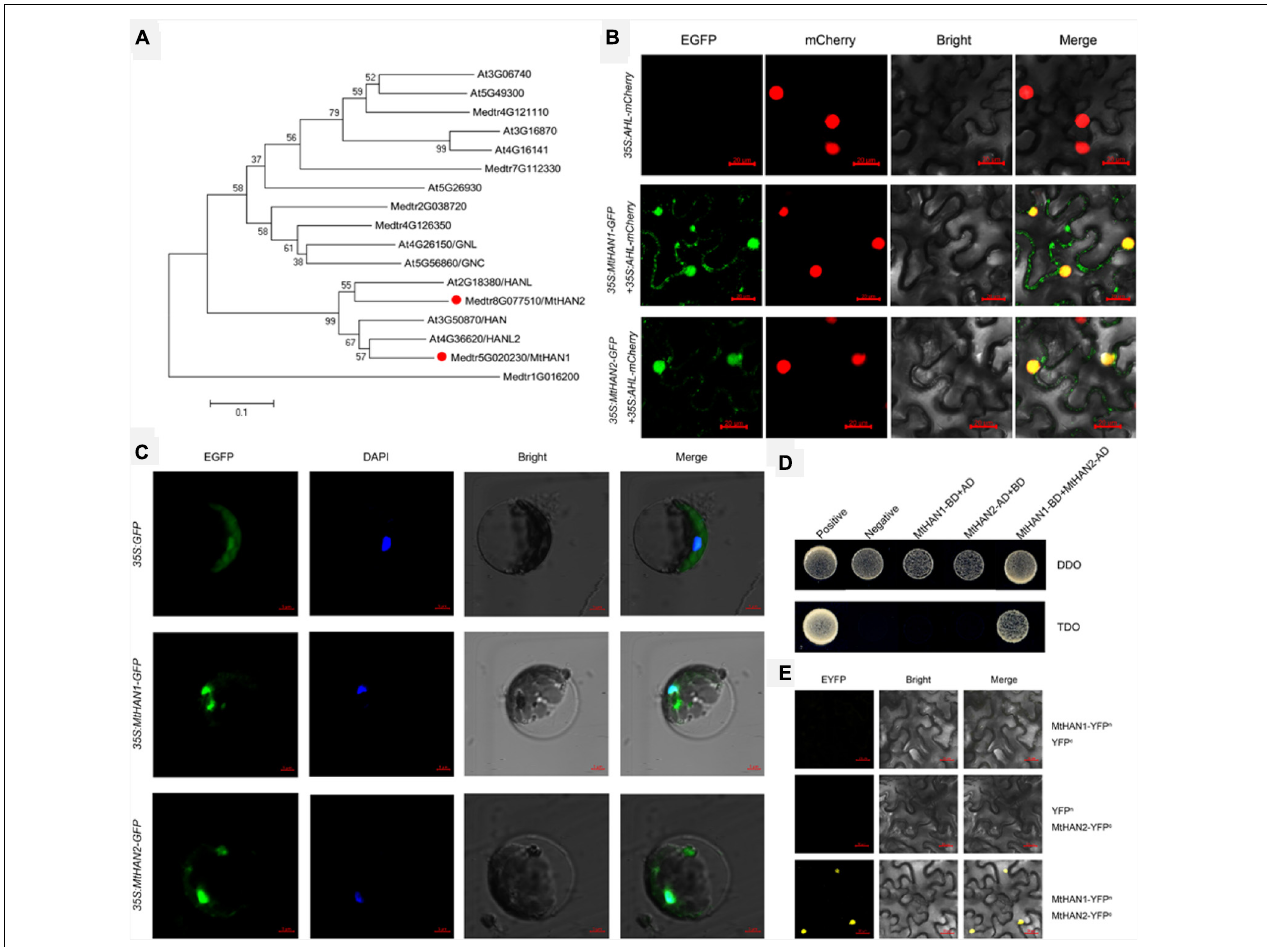
FIGURE 1 | Medicago truncatula HANABA TARANU ( HAN ) homologues interact in nucleus. (A) Phylogenetic analysis of HAN genes among different species. (B) The subcellular localization of MtHAN1 / 2 -GFP in Nicotiana benthamiana leaves. At-Hook Motif Containing Nuclear Localized (AHL)-mCherry was used as a marker for the nucleus. Bars = 20 µ m. (C) The subcellular localization of MtHAN1 / 2 -GFP in M. truncatula protoplasts. Free GFP was used as a control. Bars = 5 µ m. (D) Physical interaction between MtHAN1 and MtHAN2 by yeast two-hybrid assay. Interaction was examined by yeast grown on TDO (SD-Leu-Trp-His) medium. (E) BiFC showing the interaction between MtHAN1 and MtHAN2 in nucleus. Bars = 20 µ